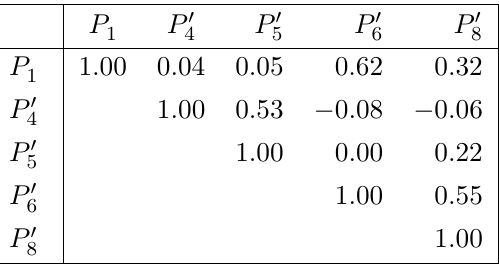
Table 5 . Statistical correlation matrix for the P (